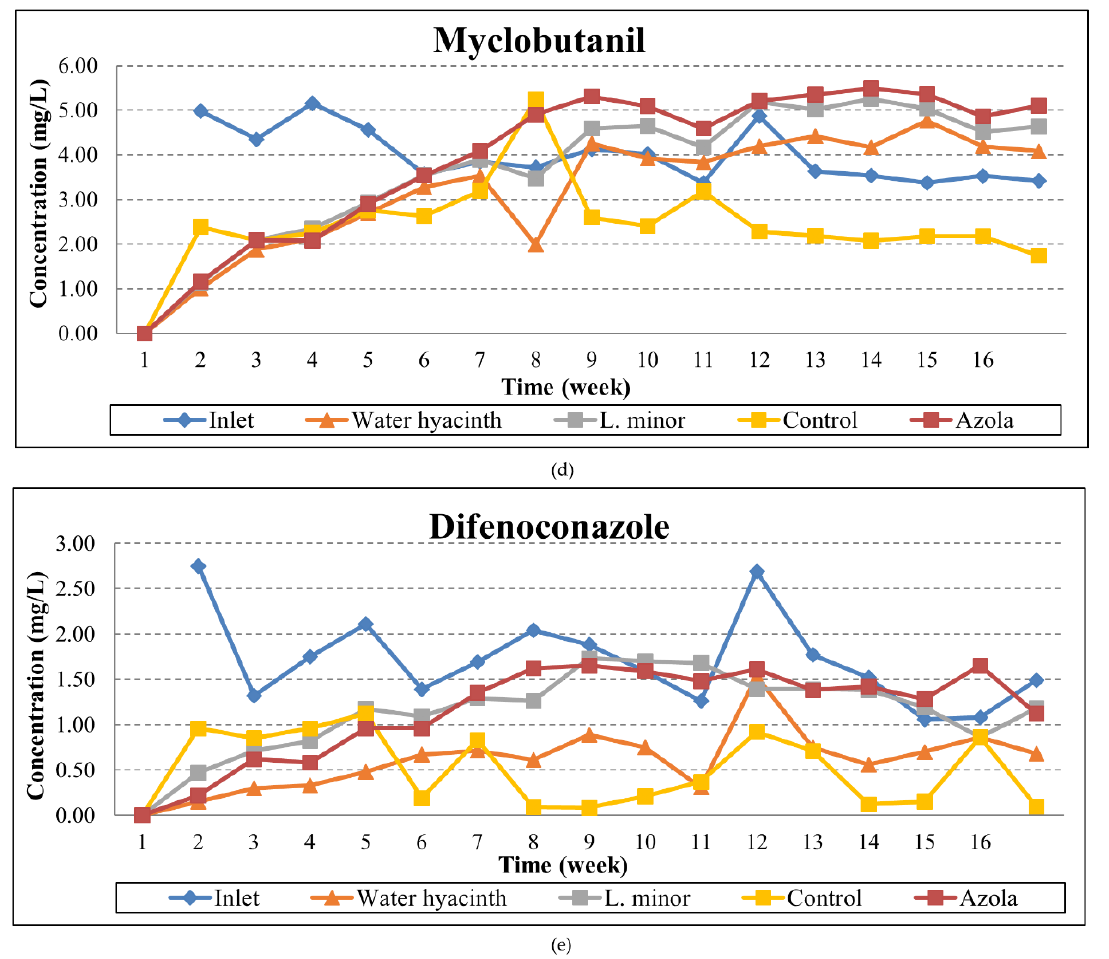
Figure 7. Temporal variation of: ( a ) Imidacloprid, ( b ) Thiacloprid, ( c ) Dimethomorph, ( d ) Myclobutanil and ( e ) Difenoconazole concentrations at the inlet and outlet of the three tanks throughout the operation period.